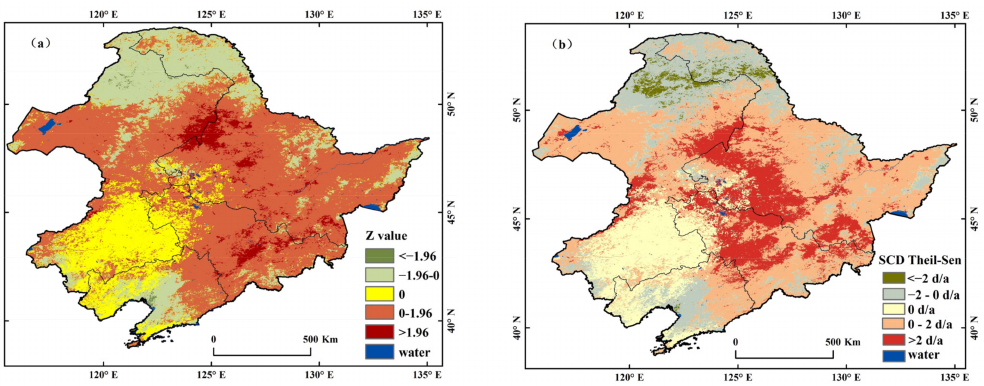
Figure 5. Trend of SCD in Northeast China. ( a ) Significance test and ( b ) trend of SCD from HY2001 to HY2017.